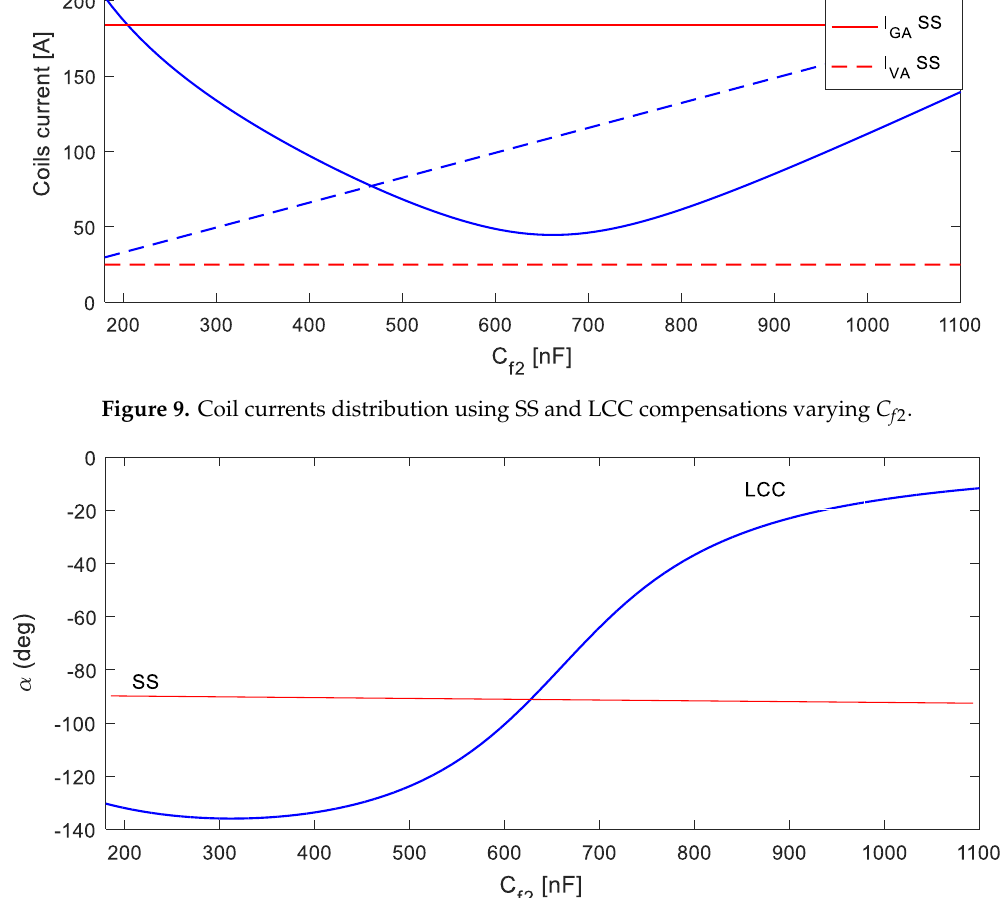
Figure 10. Phase of currents I GA and I VA using SS and LCC compensations varying C f 2 .